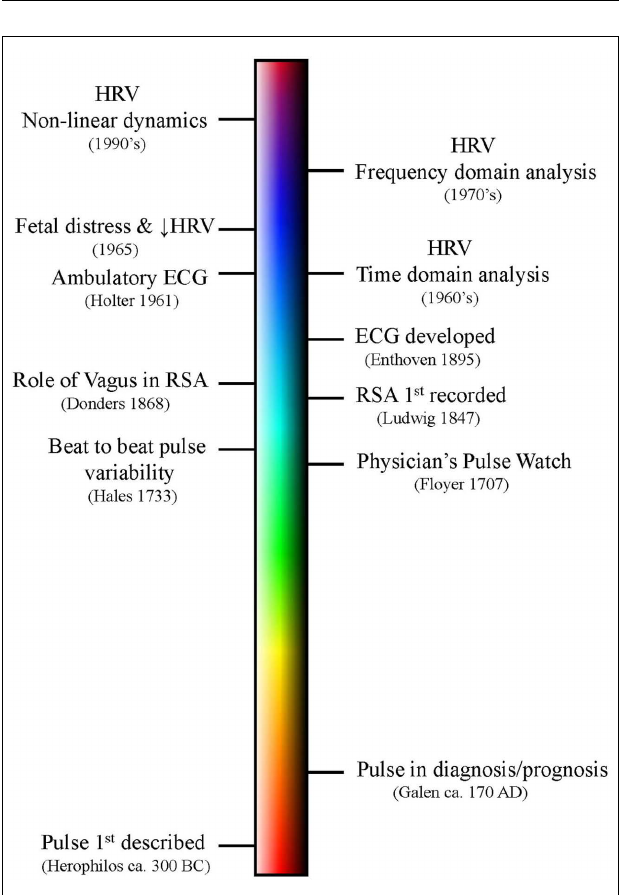
FIGURE 2 |A timeline of some of the major events in the discovery of heart rate variability (HRV). Please note that the timeline is not drawn to scale.